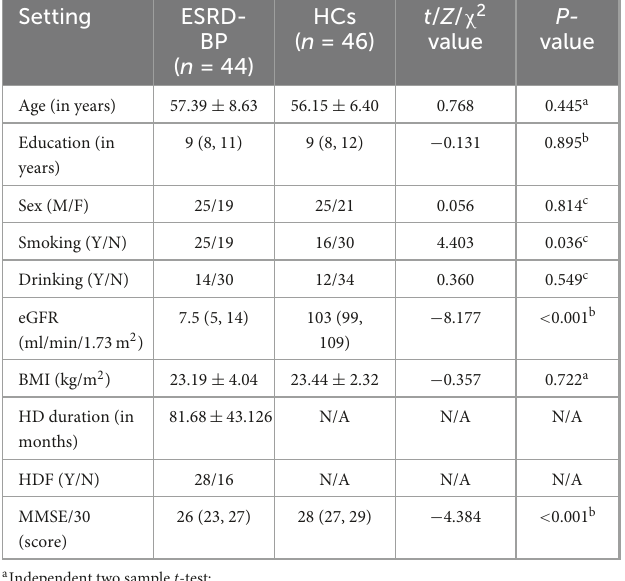
TABLE 1 Demographics between ESRD-BP and HCs